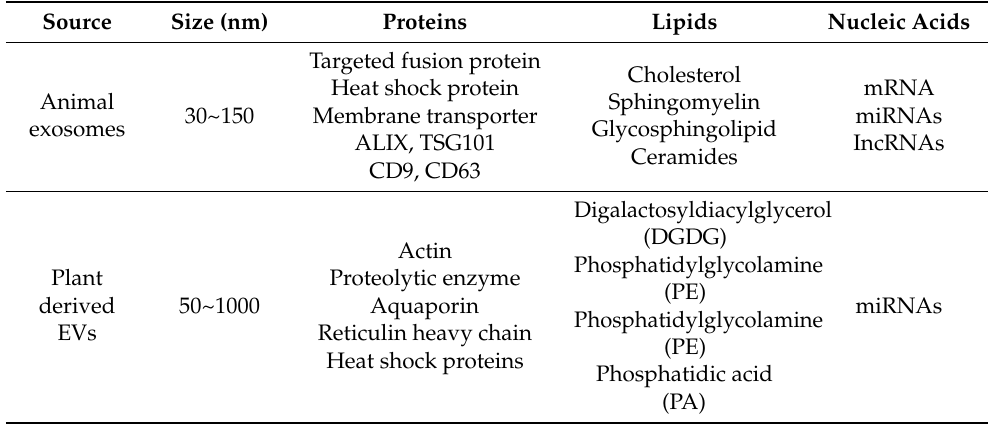
Table 1. The Difference between Animal Exosomes and Plant derived EVs in Size, Proteins, Lipids, Nucleic Acids. Source Size (nm) Proteins Lipids Nucleic Acids